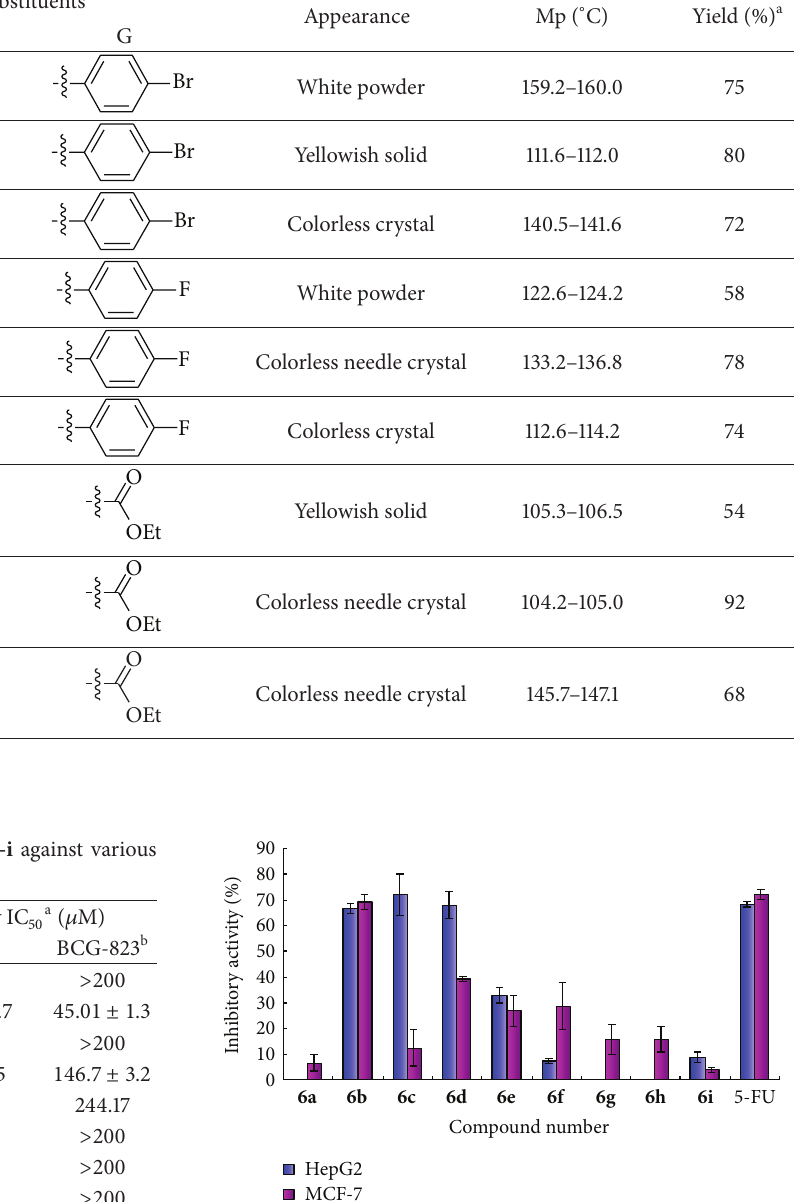
Figure 3: Inhibition activities against cell proliferation for com- pounds 6a–i at 40 𝜇 g/mL. Abbreviations: HepG2: human hepato- cellular liver carcinoma cell line; MCF-7: human breast adenocarci- noma cell line; 5-FU: 5-fluorouracil, used as a positive